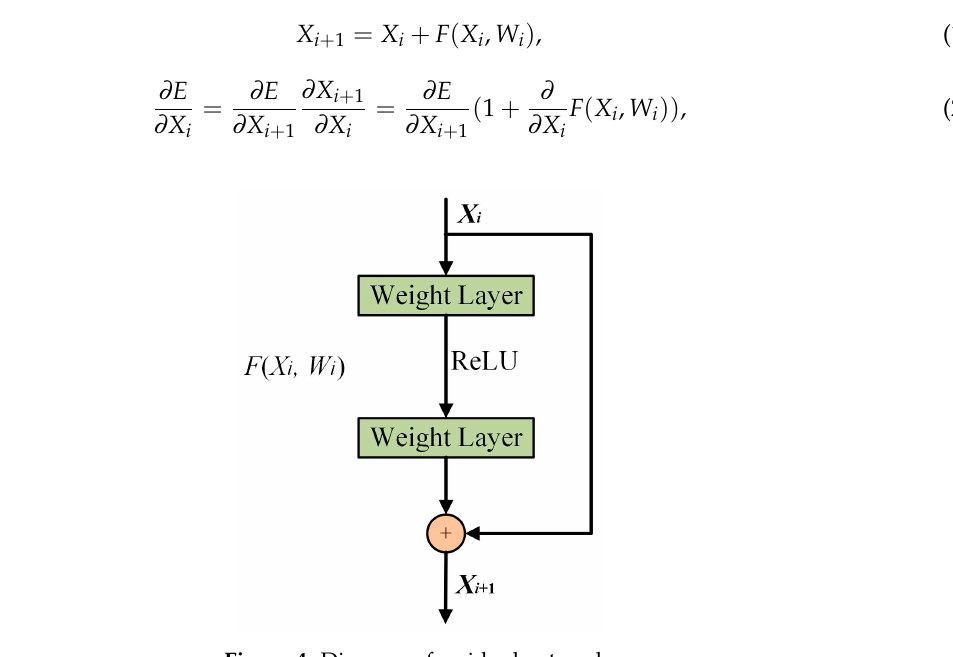
Figure 4. Diagram of residual network.